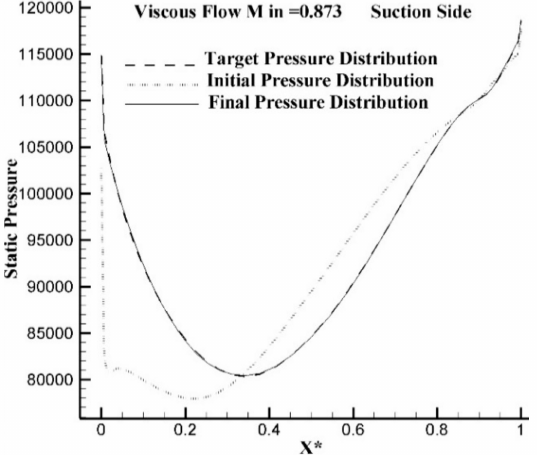
Figure 7. Initial, target, and final pressure distributions on the suction surface versus non- dimensionalized X*—coordinate, in the validation of original UESA at AOA = 1 ◦ (Mach inlet = 0.87). 2.5. Validation of UESA for the Cascade with Transonic Flow (Mach Inlet = 0.96)